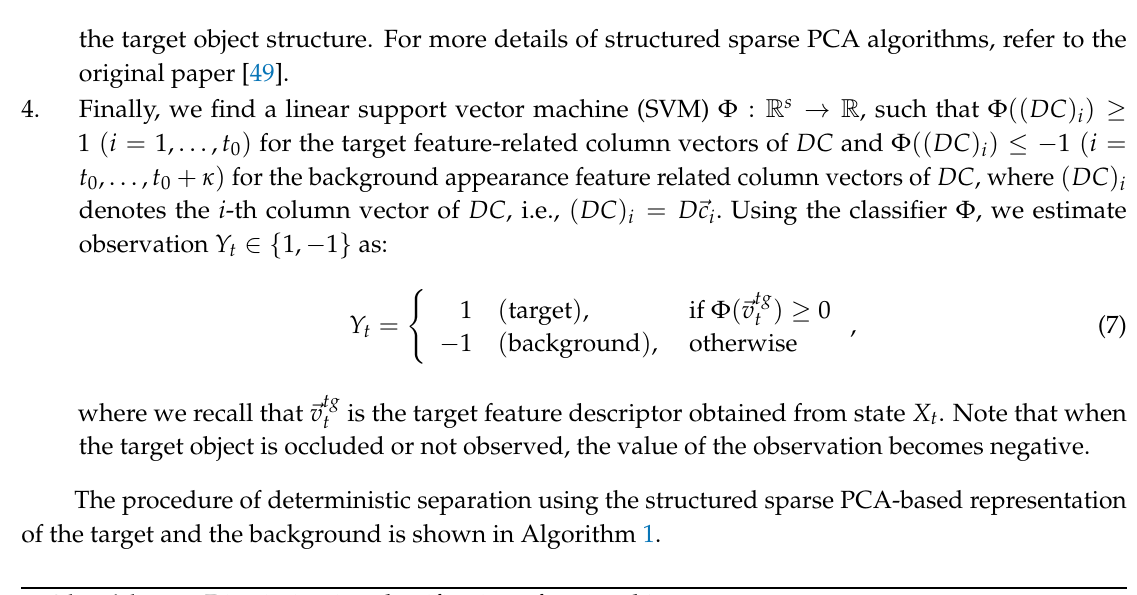
Algorithm 1: Discriminative classification of target